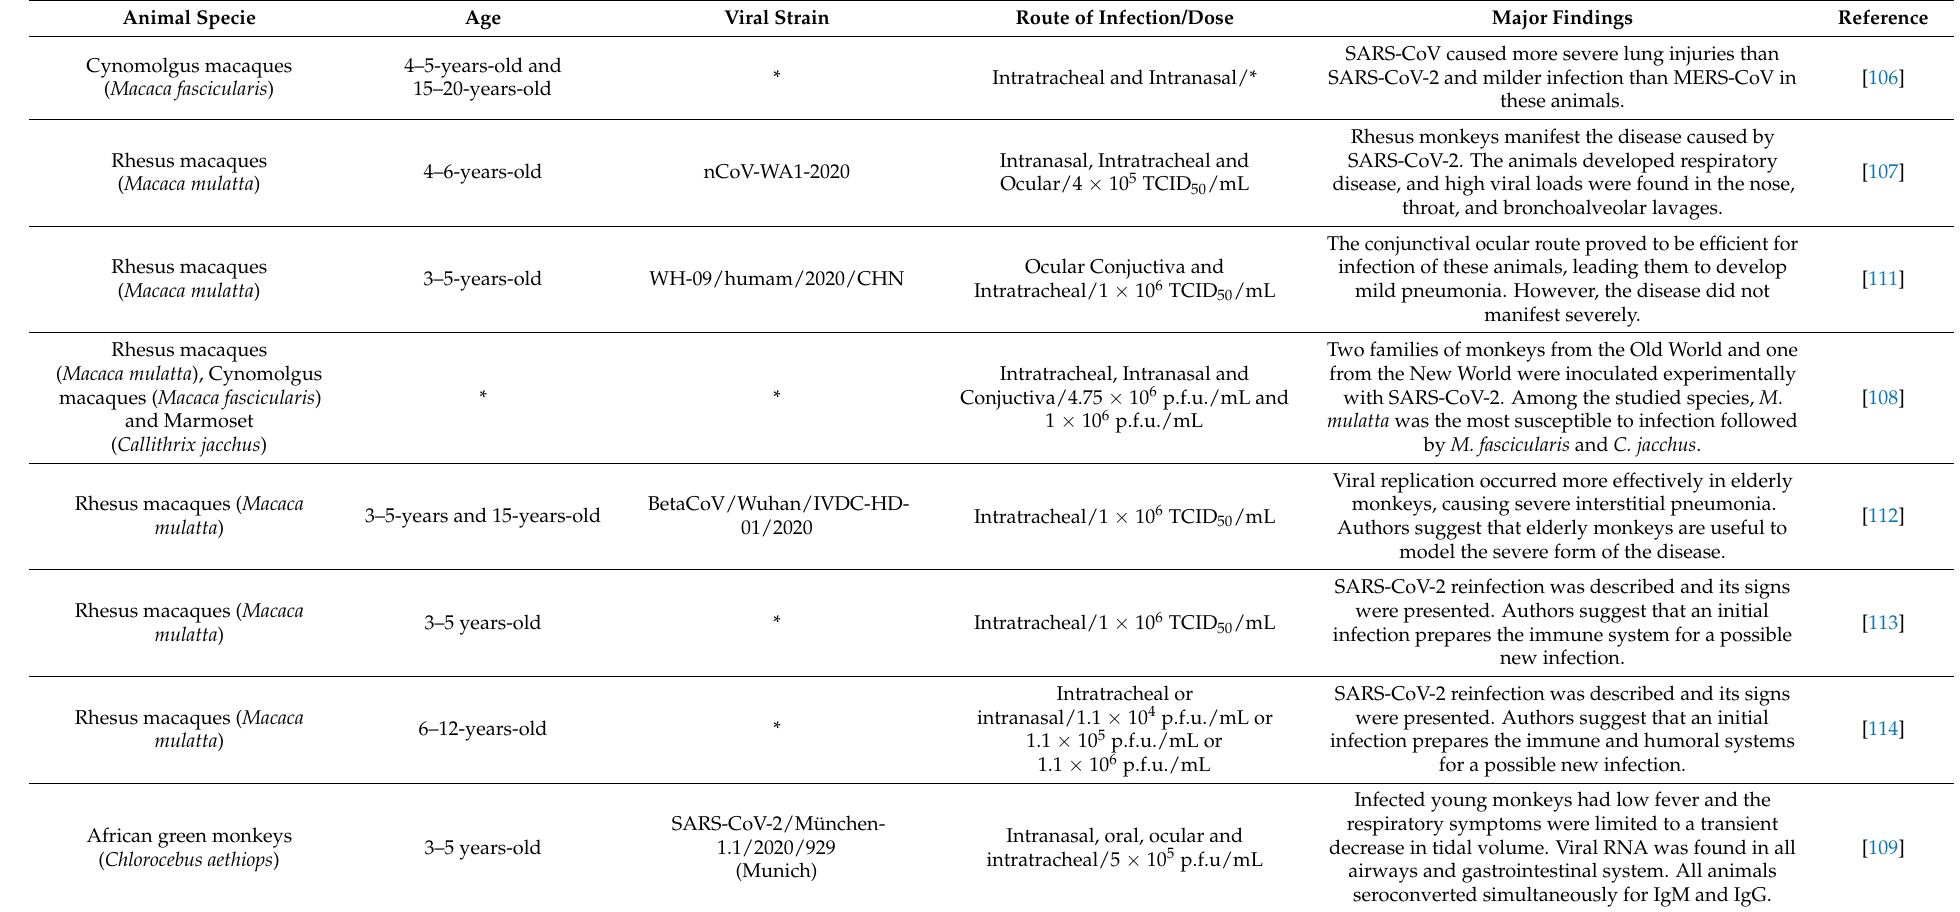
Table 4. Non-human primate models for SARS-CoV-2